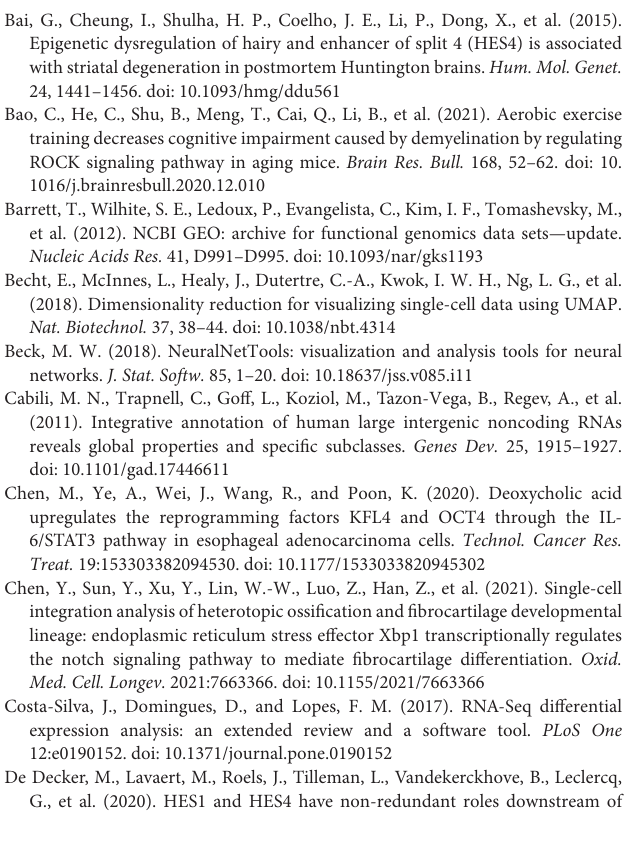
Supplementary Figure 3 | Key transcriptome clusters of monocytes affected by exercise in AD patients with pseudotime analysis. (A) Distinct cell types’ transcriptional regulatory activity in different cell modules; (B) All CD14 + and CD16 + monocytes were subjected to a principal component analysis (PCA); (C) Scatter plots of APP , CCR1 , TNF , ATF3 , KLF4 , HES4 , and MAFB expression profiles; (D) Distribution of CD14 + and CD16 + monocytes on pseudotime trajectories, pseudotime value distribution plots, and pseudotime trajectories branching (E) . APP , CCR1 , TNF , ATF3 , KLF4 , HES4 , and MAFB expression levels in relation to pseudo-time; (F) In the post-exercise bulk RNA collection, these seven important genes of APP , CCR1 , TNF , ATF3 , HES4 , and KLF4 were discovered to be tightly related. Supplementary Figure 4 | The ERADMT gene set was found to be a potential risk marker for the development of patients with AD. (A) Correlation analysis of APP , CCR1 , TNF , ATF3 , KLF4 , HES4 , and MAFB in the GSE140831 dataset; (B,C) The box plot shows that the model residuals of SVM are larger than those of RF model; (D) Relationship between the “error” of the RF model and number of selected trees of the model; (E) Ranking of ERADMT genes according to their importance; (F) Predictive power of RF and SVM models with predictive power demonstrated by the ROC curves; (G) The nomogram prediction model constructed with the expression features of the ERADMT gene set; (H) The nomogram prediction model’s calibration curve based on the ERADMT gene set. Supplementary Figure 5 | The ERADMT gene set prediction AD risk column nomogram prediction model’s predictive power was evaluated; (A) Decision Curve Analysis (DCA) curves of the nomogram prediction model based on the ERADMT gene set; (B) The nomogram prediction model based on the ERADMT gene set underwent